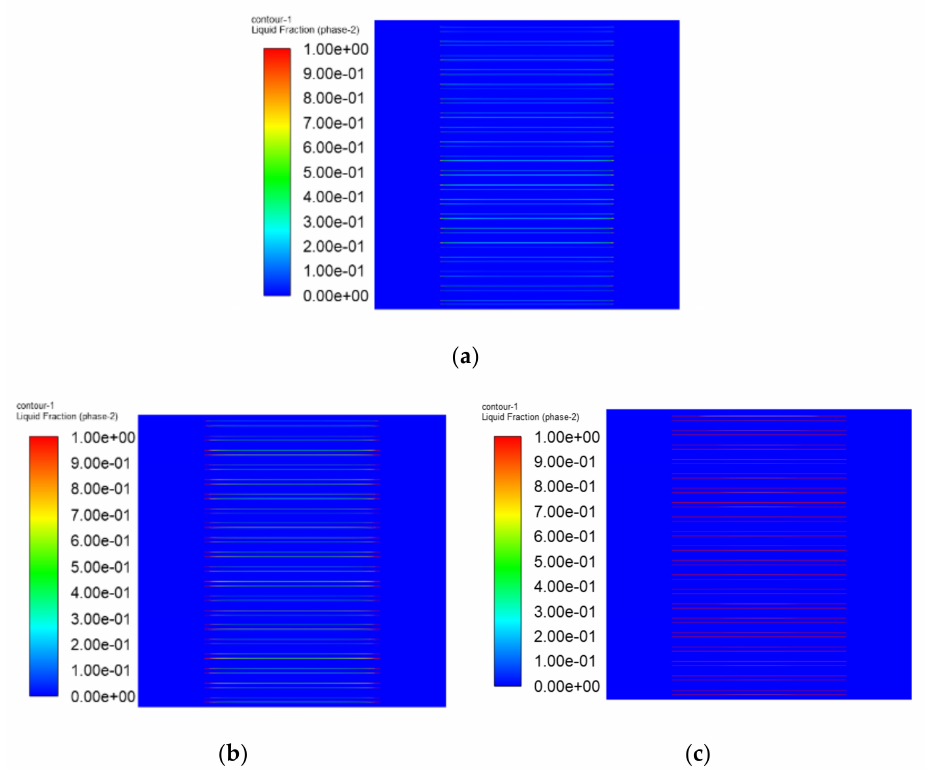
Figure 11. Liquid fraction contours of the PEMFC stack at di ff erent times; ( a ) t = 24 s, ( b ) t = 28 s, ( c ) t = 32 s.